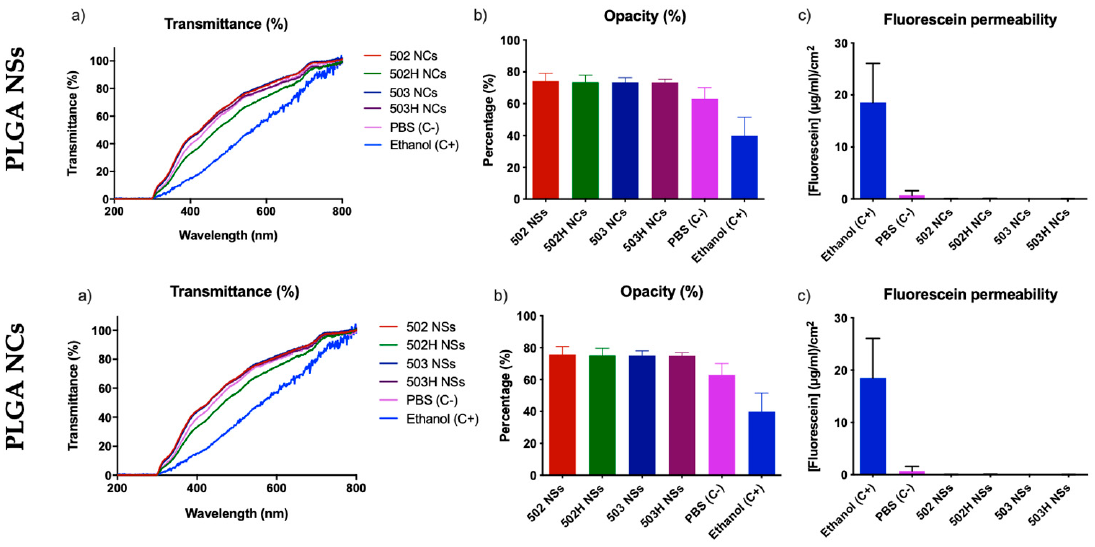
Figure 13. Resulting data of the BCOP test for PLGA-based NSs ( top ) and NCS ( bottom ). ( a ) final corneal transparency values measured by UV-Vis spectrophotometry; ( b ) final corneal transparency values measured by luxmetry, and ( c ) fluorescein permeability measured by UV-Vis spectrophotometry. 4.5.2. Hen’s Egg Test on the Chorioallantoic Membrane (HET-CAM)